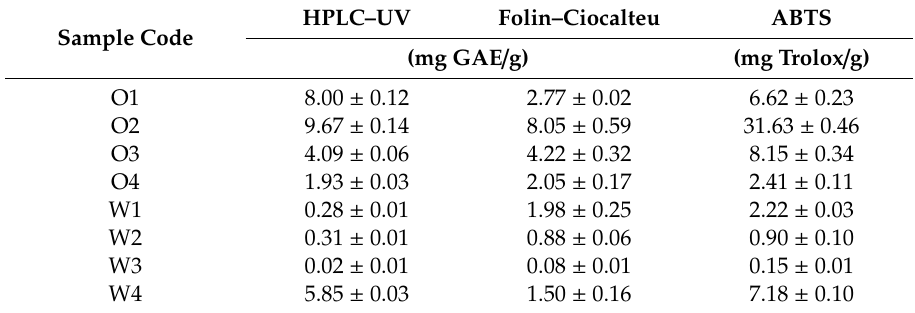
Folin–Ciocalteu, and ABTS